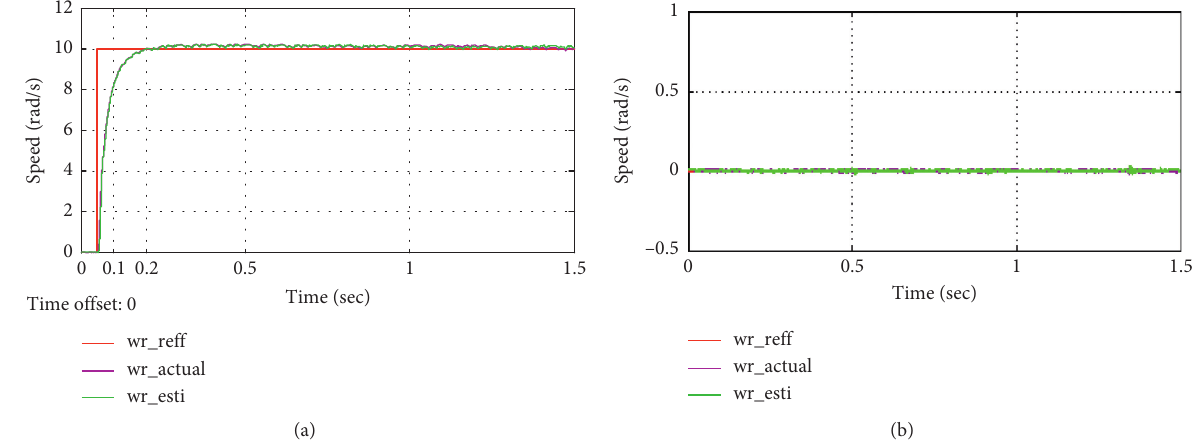
Figure 11: Step response for 10rad/s and zero rad/s speed response with no load